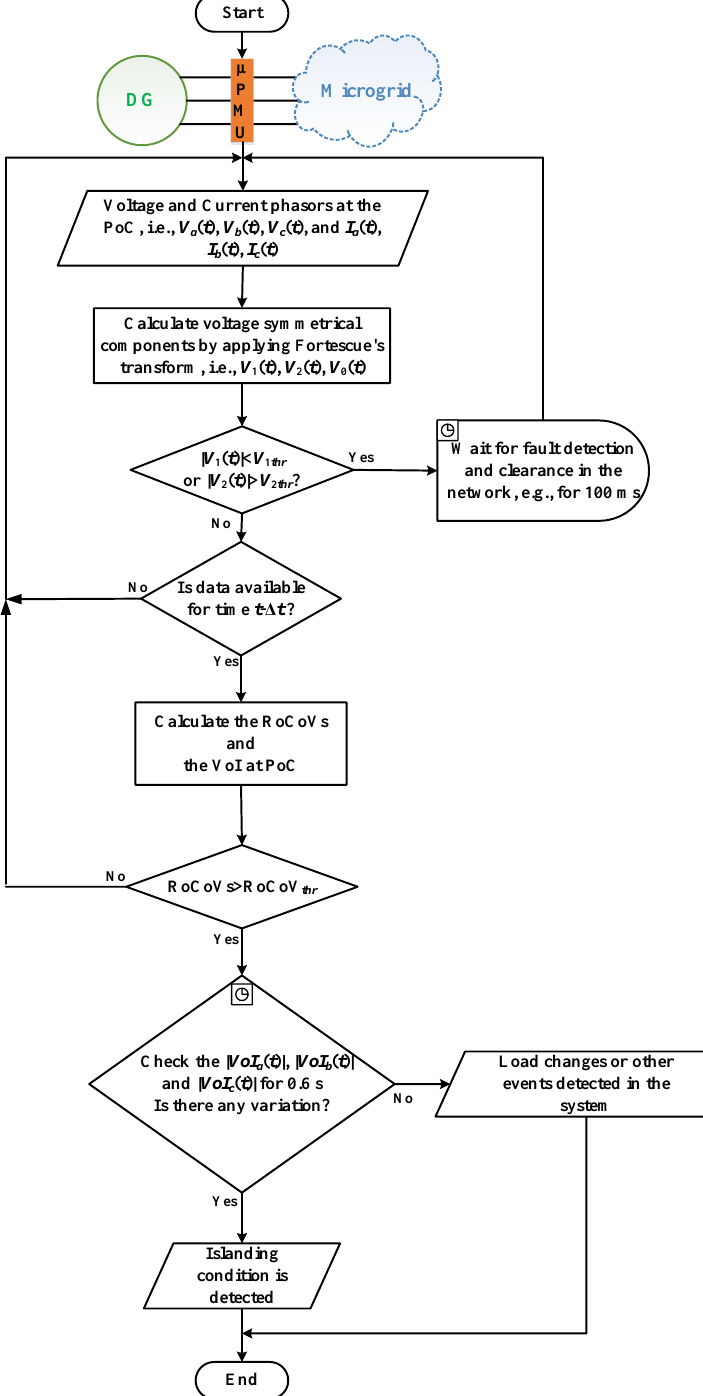
Figure 4. The flowchart of the proposed passive islanding detection technique.